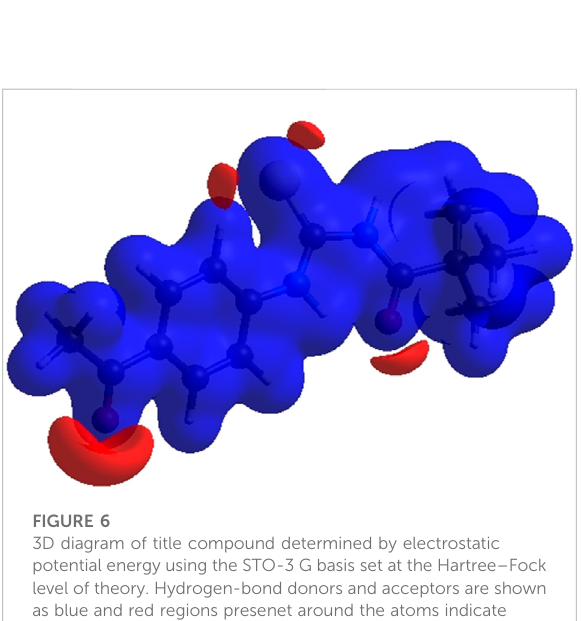
FIGURE 5 3D diagram of title compound plotted over d norm with range (-0.0688 to 1.3807 a. u).